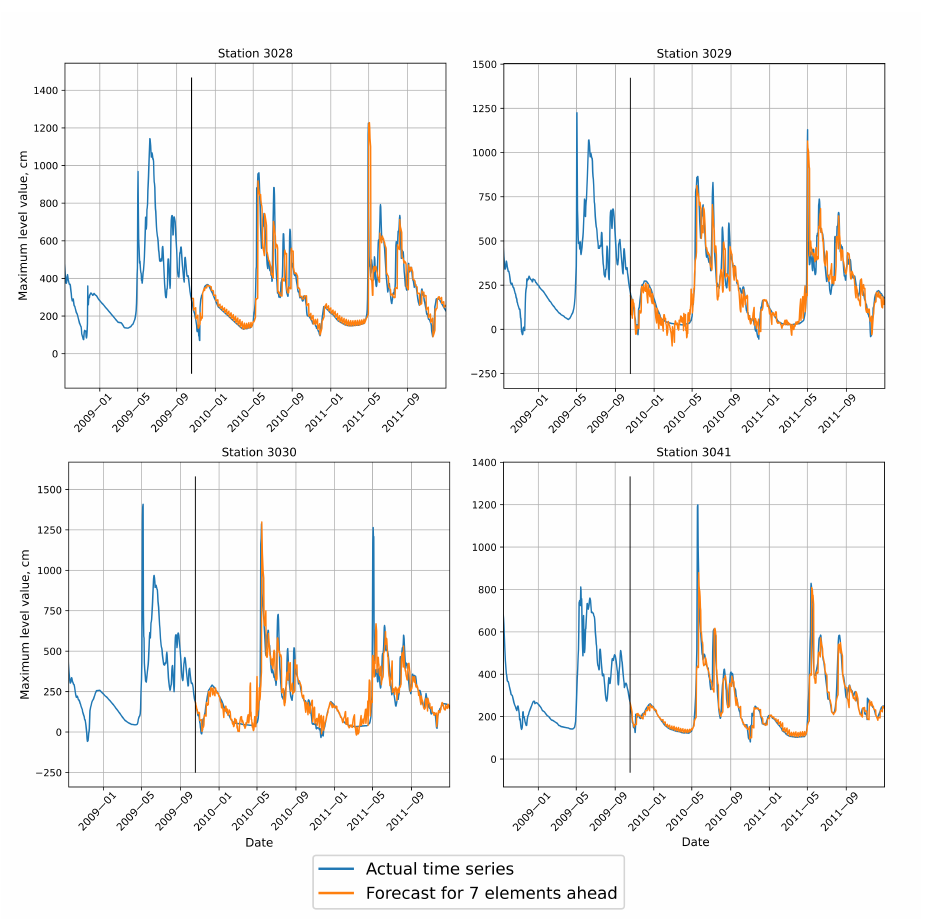
Figure 13. Validation of time series forecasting model for several hydro gauges. Forecasting horizon— seven